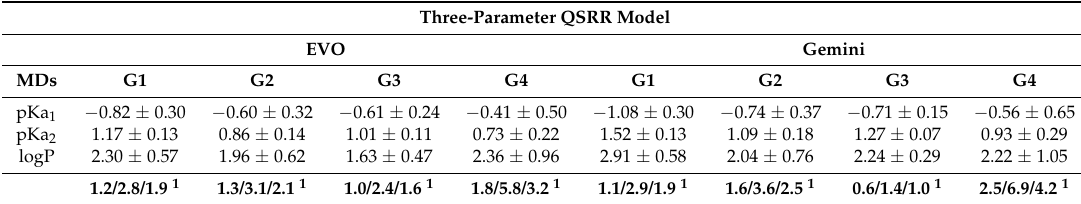
Table 4. QSRR models, based on Equation (2), describing the retention of tryptophan and its major metabolites for each chromatographic column.